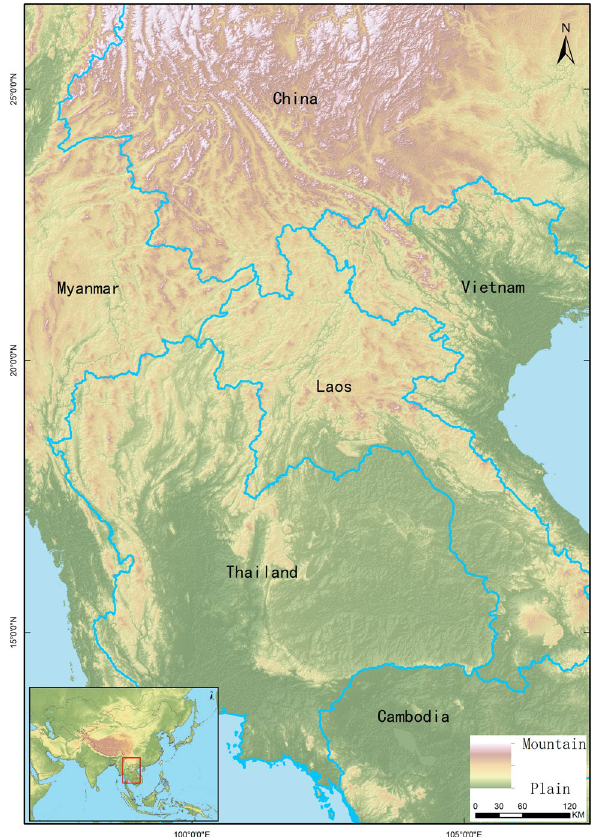
Figure 1. Research area. The elevation depicted by the digital elevation model (DEM). DEM was obtained from USGS Earth Explorer (https:// www. earth explo rer. usgs. gov); the boundary was obtained from Natural Earth (http:// www. natur alear thdata. com/), which is a schematic line illustrating the relative position of each country and should not be re-used or misinterpreted for any political